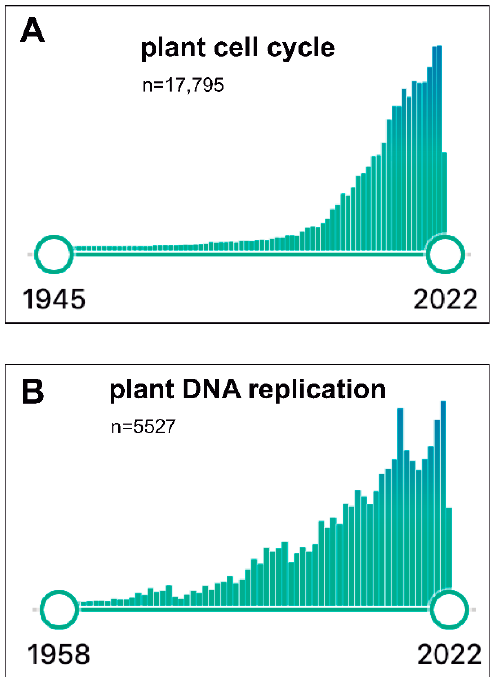
Figure 1. Timeline results of publications recorded in PubMed (June 2022) for the terms “plant cell cycle” ( A ) and “plant DNA replication” ( B ).